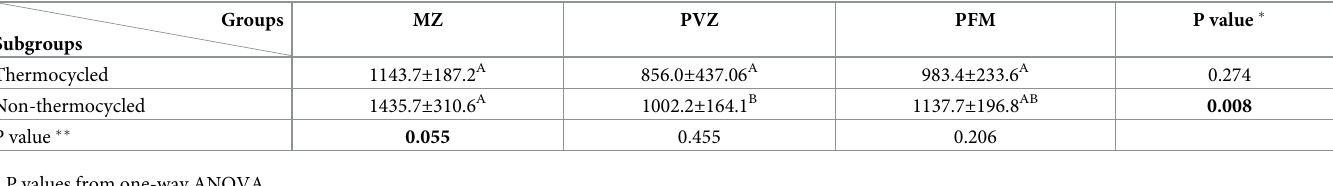
Table 1. Mean and standard deviations and multiple comparisons of fractural load among the study groups (N).